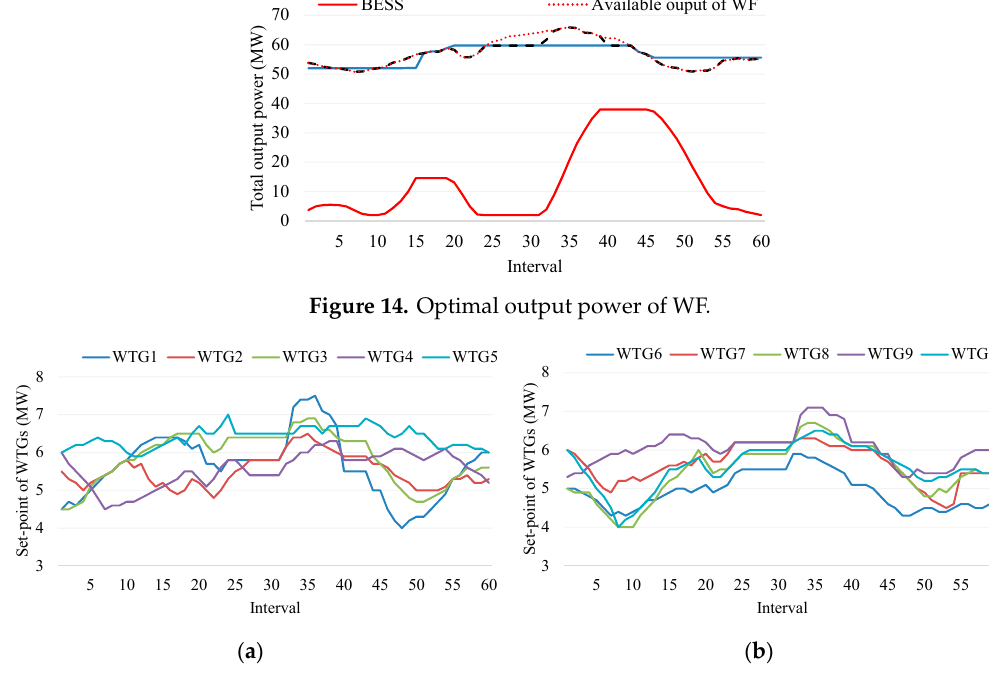
Figure 15. Optimal set-points of WTGs in WF: ( a ) Cluster 1; ( b ) Cluster 2.